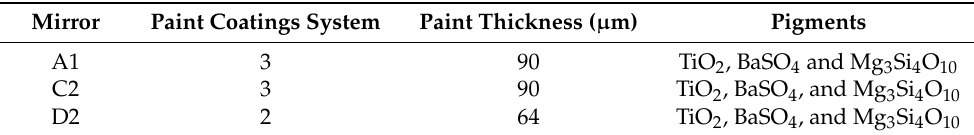
Table 2. Description of paint systems used in each tested mirror.